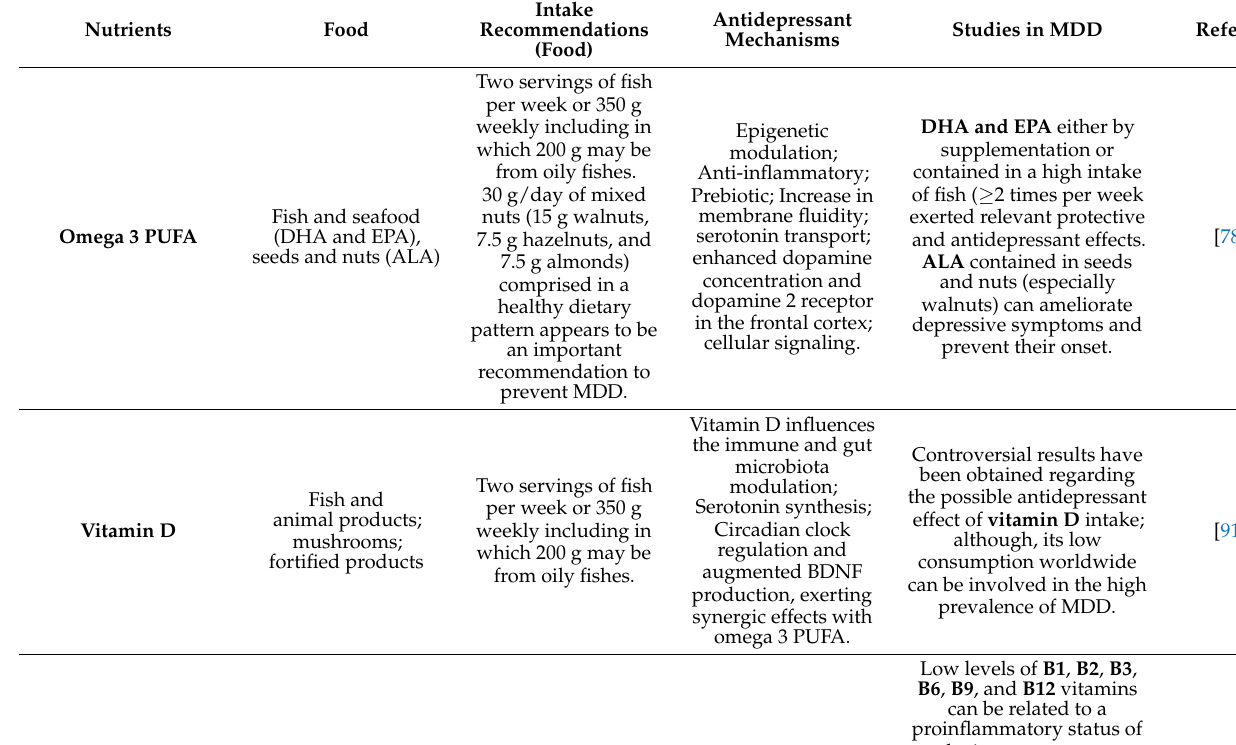
Table 1. Main nutrients and dietary recommendations with potential antidepressant